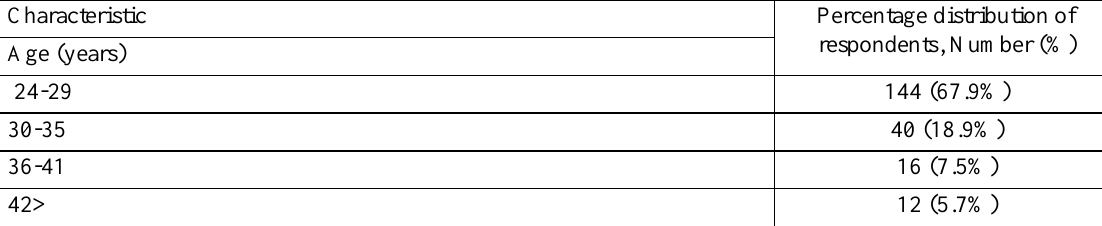
Table 1. Sociodemographic characteristics of the study participants